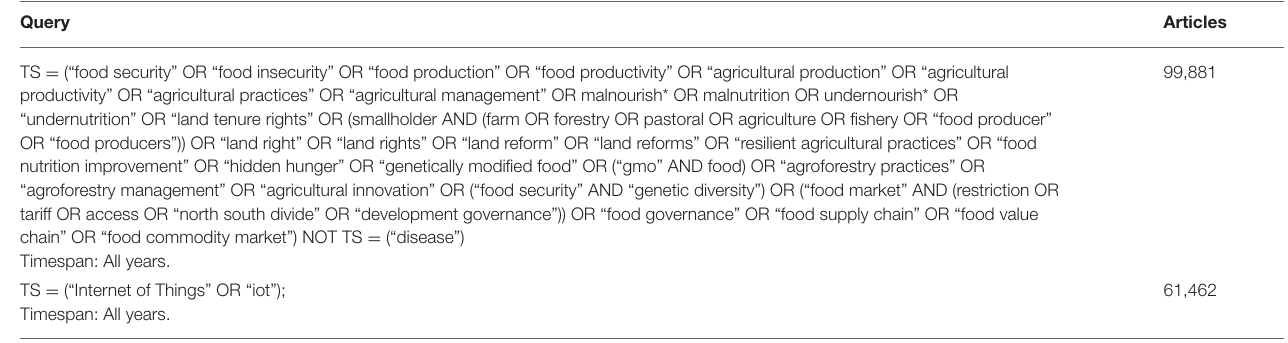
TABLE 1 | Search queries for extracting academic articles on food security and